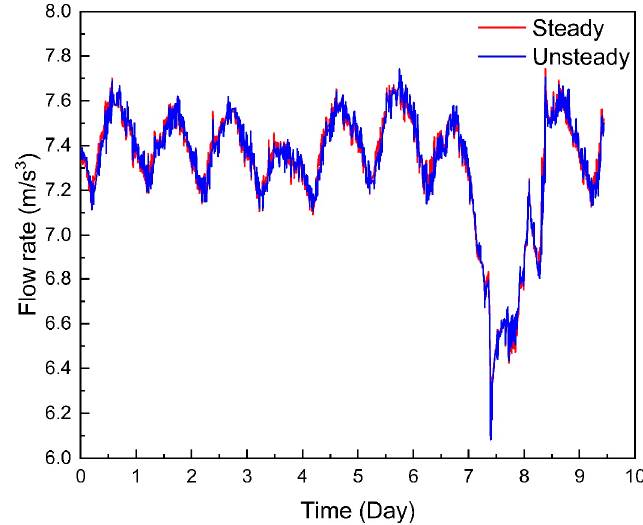
Figure 5. Flow rate comparison.